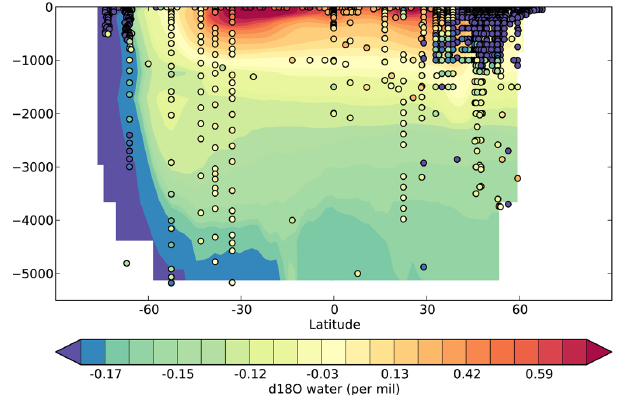
Fig. 13. Atlantic zonal mean for the δ 18 O of seawater in i LOVECLIM compared to the GISS database (Schmidt et al., 1999) (coloured scale) presented as a latitudinal–depth (m) transect.